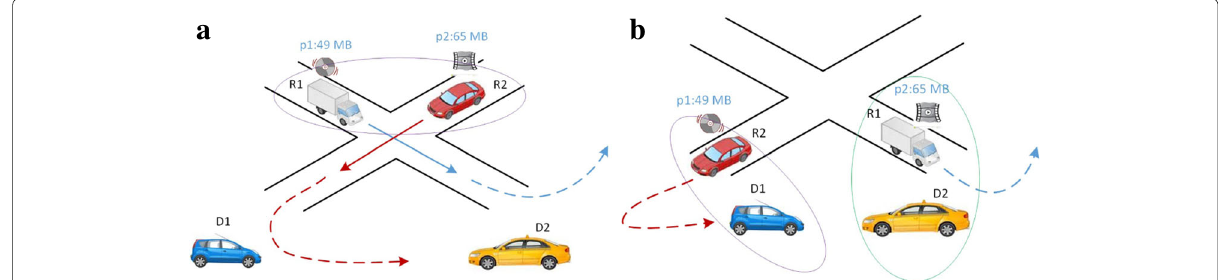
Fig. 1 An example to show the challenge in proposed scenario. The relay vehicle R 1 holds an audio clip p 1 to the destination vehicle D 1 while the relay vehicle R 2 tries to send a video clip p 2 to the destination vehicle D 2 . Each vehicle can only hold one data content due to storage limitation. The arrows show their moving directions. a First, R 1 meets R 2 . b Then, relays meet their